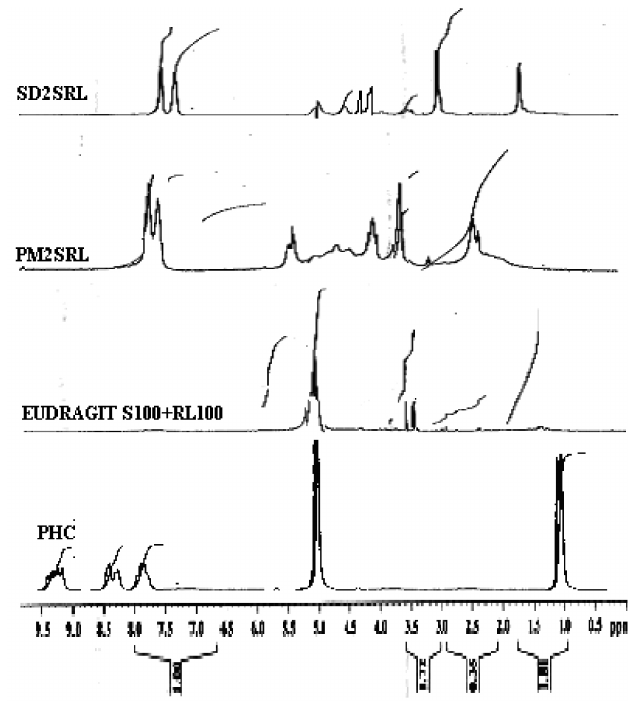
FIGURE 9 - SEM Images of Pure drug, polymers, PM2SRL and